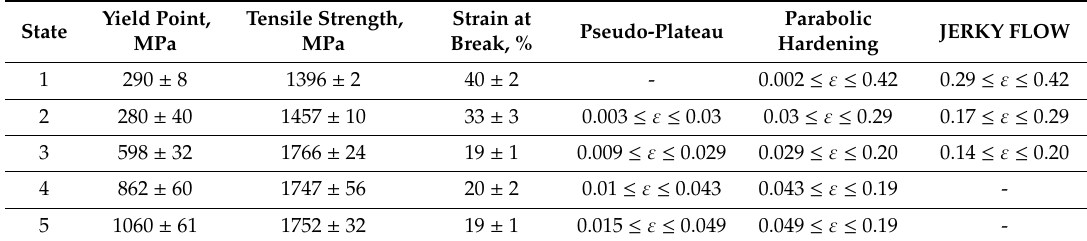
Table 5. Mechanical Characteristics of TRIP Steel Specimens and the Length of the Loading Curve